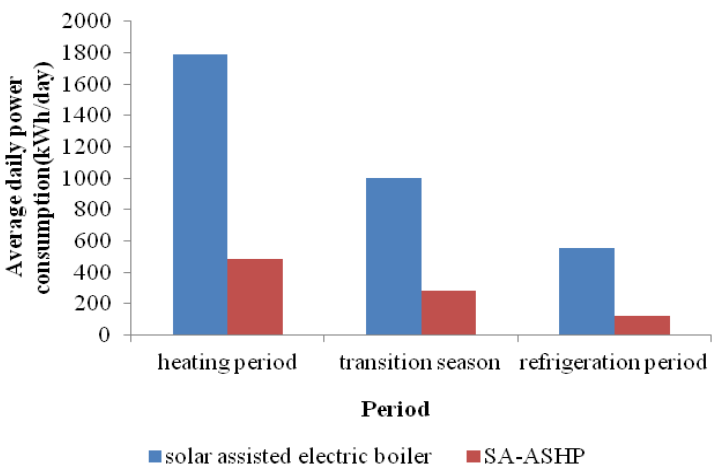
Figure 5. Average daily power consumption of the two water heating systems.